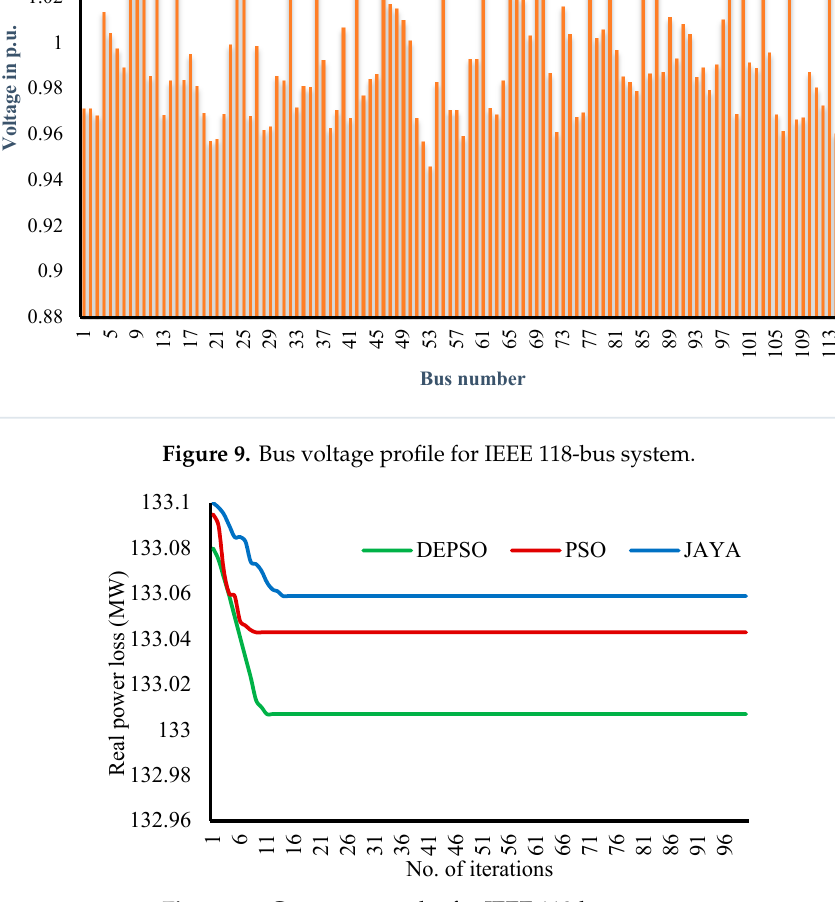
Figure 10. Convergence plot for IEEE 118-bus system.